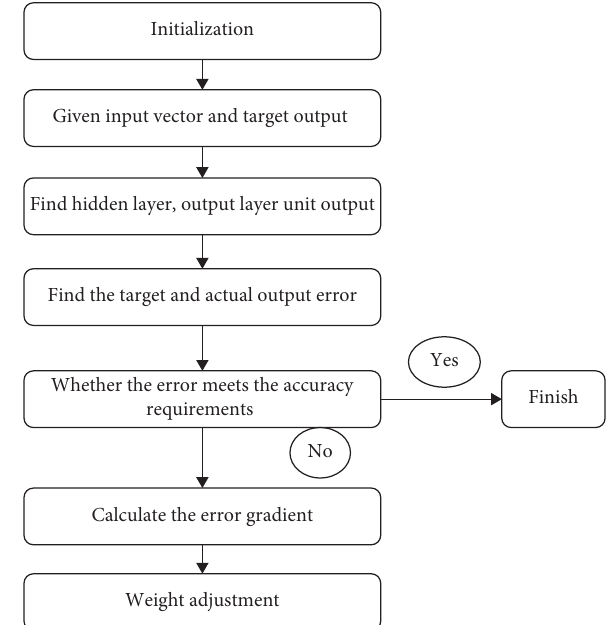
Figure 1: CAD auxiliary intelligent calculation